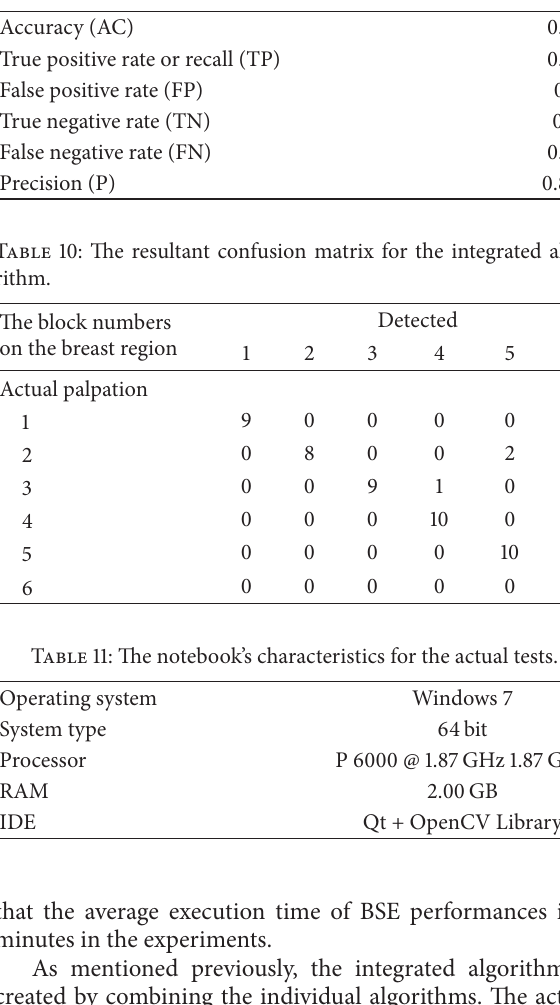
Table 9: Performance of palpation detection evaluation.